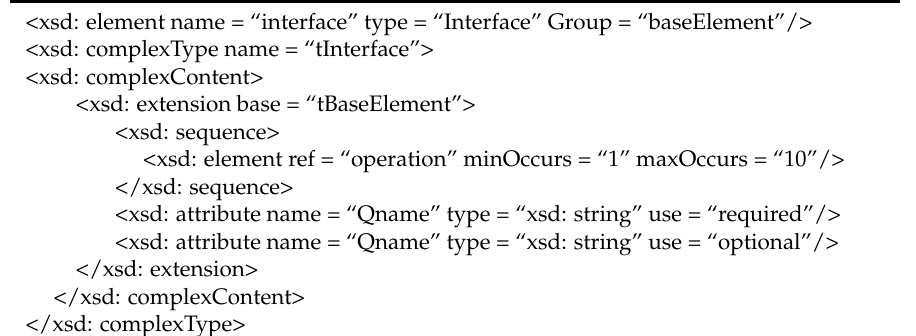
Table 2. Interface XML schema definition (XSD)